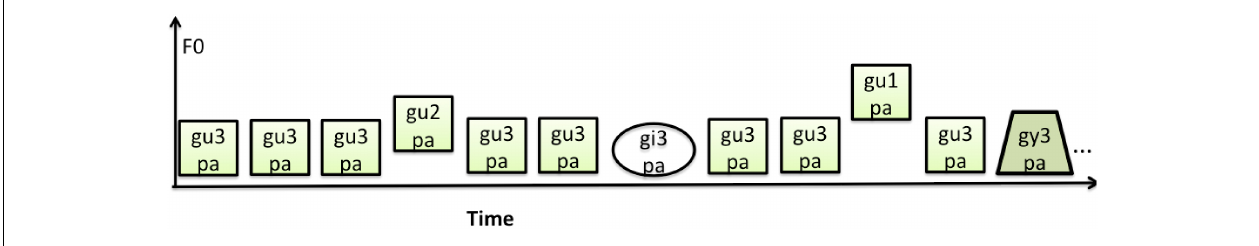
FIGURE 1 | Schematic of the experimental